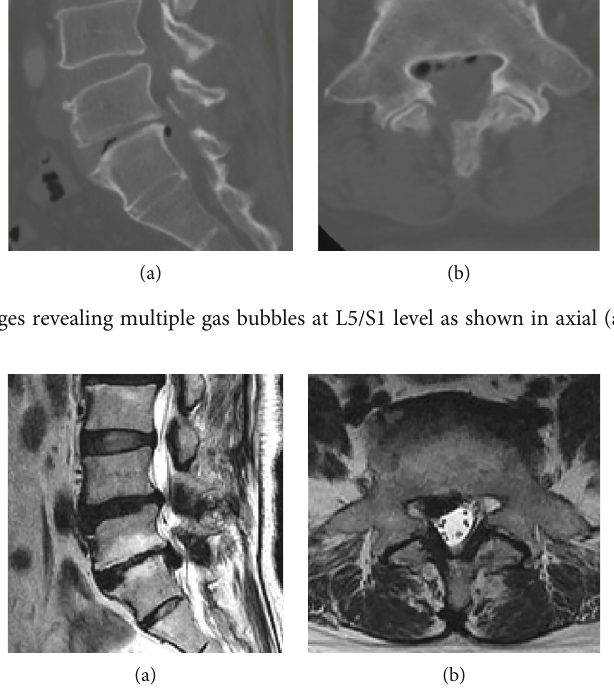
Figure 2: T2 sequences in sagittal (a) and axial orientation (b) illustrate a caudally shifted hypointense mass in the right lateral recessus L5/ S1 with contact to the nerve root S1 suspicious of a sequestered disc herniation.